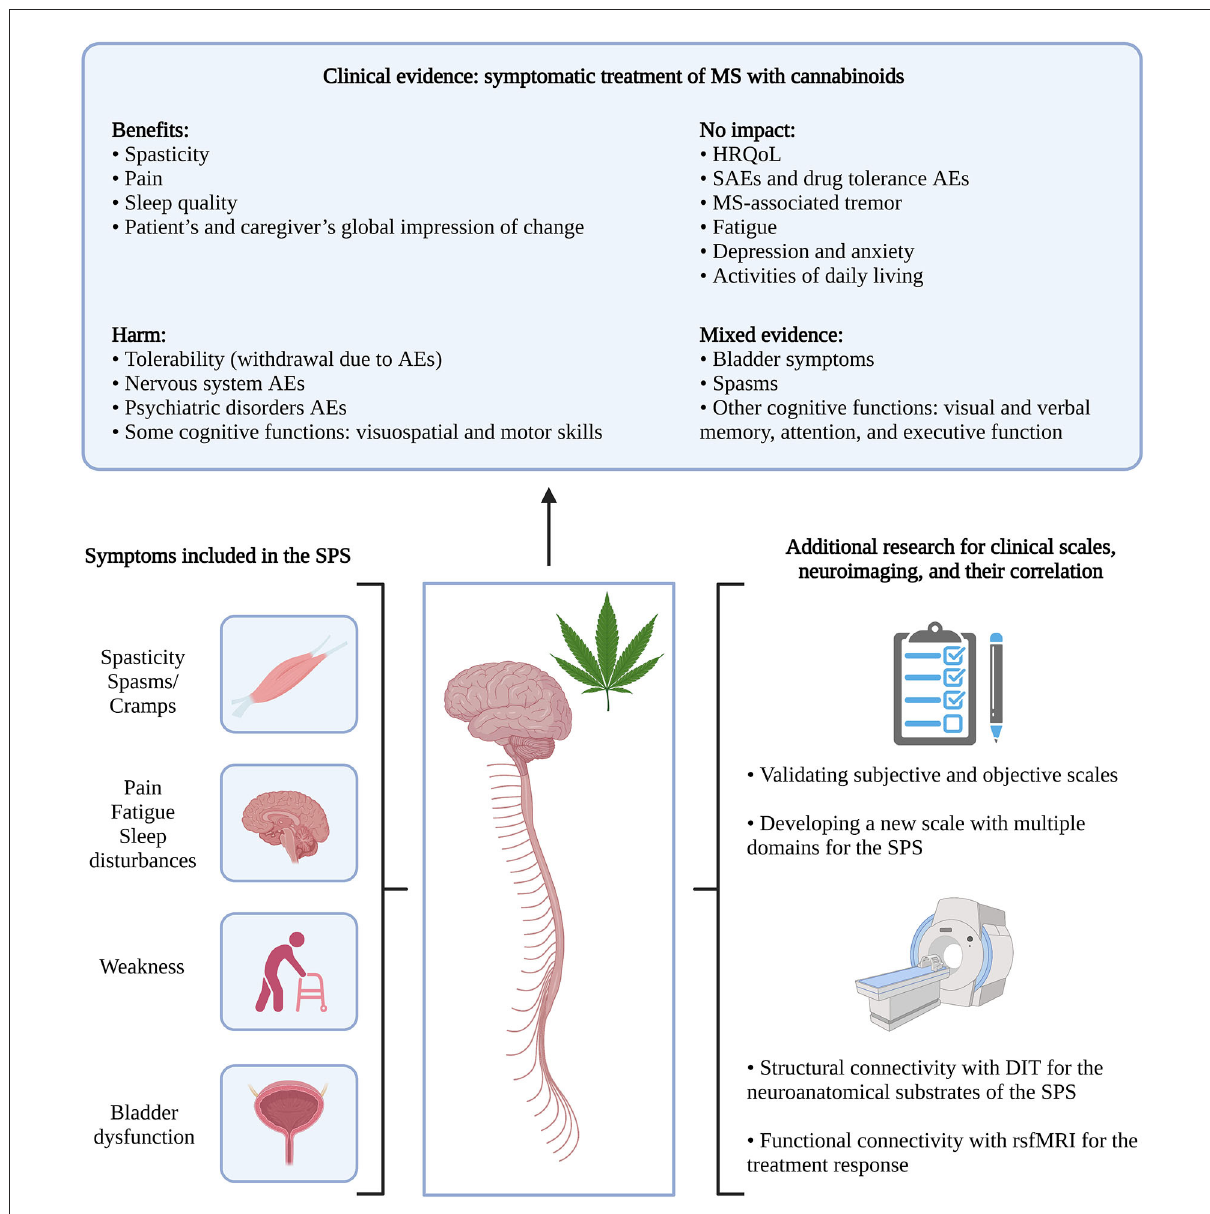
FIGURE1 From the clinical evidence of MS symptomatic therapy with cannabinoids to the SPS. Clinical evidence was retrieved from systematic literature reviews by Filippini et al. (5) and Landrigan et al. (6). MS, spasticity; AEs, adverse events; HRQoL, health-related quality of life; SAEs, serious adverse events; SPS, spasticity-plus syndrome; DIT, diffusion imaging tractography; rsfMRI, resting-state functional magnetic resonance imaging. Created with